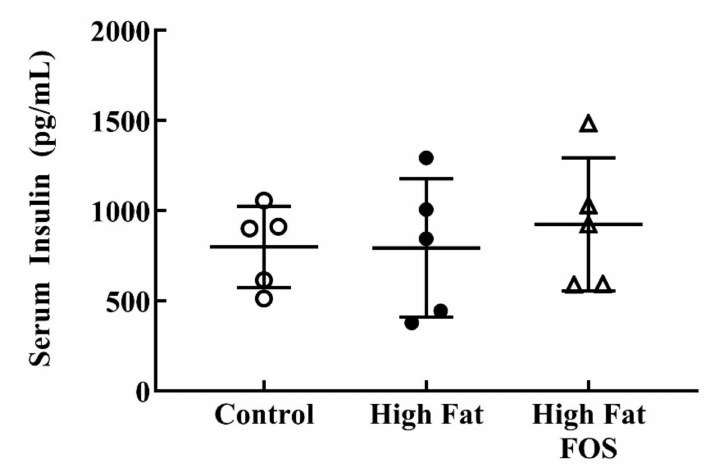
Figure 3. Non-fasting serum insulin (mean ± standard deviation) for control, high-fat, and high fat-FOS ( n = 5 each group) after 12 weeks were not significant by ANOVA. Glucose and insulin were not measured for all animals in a